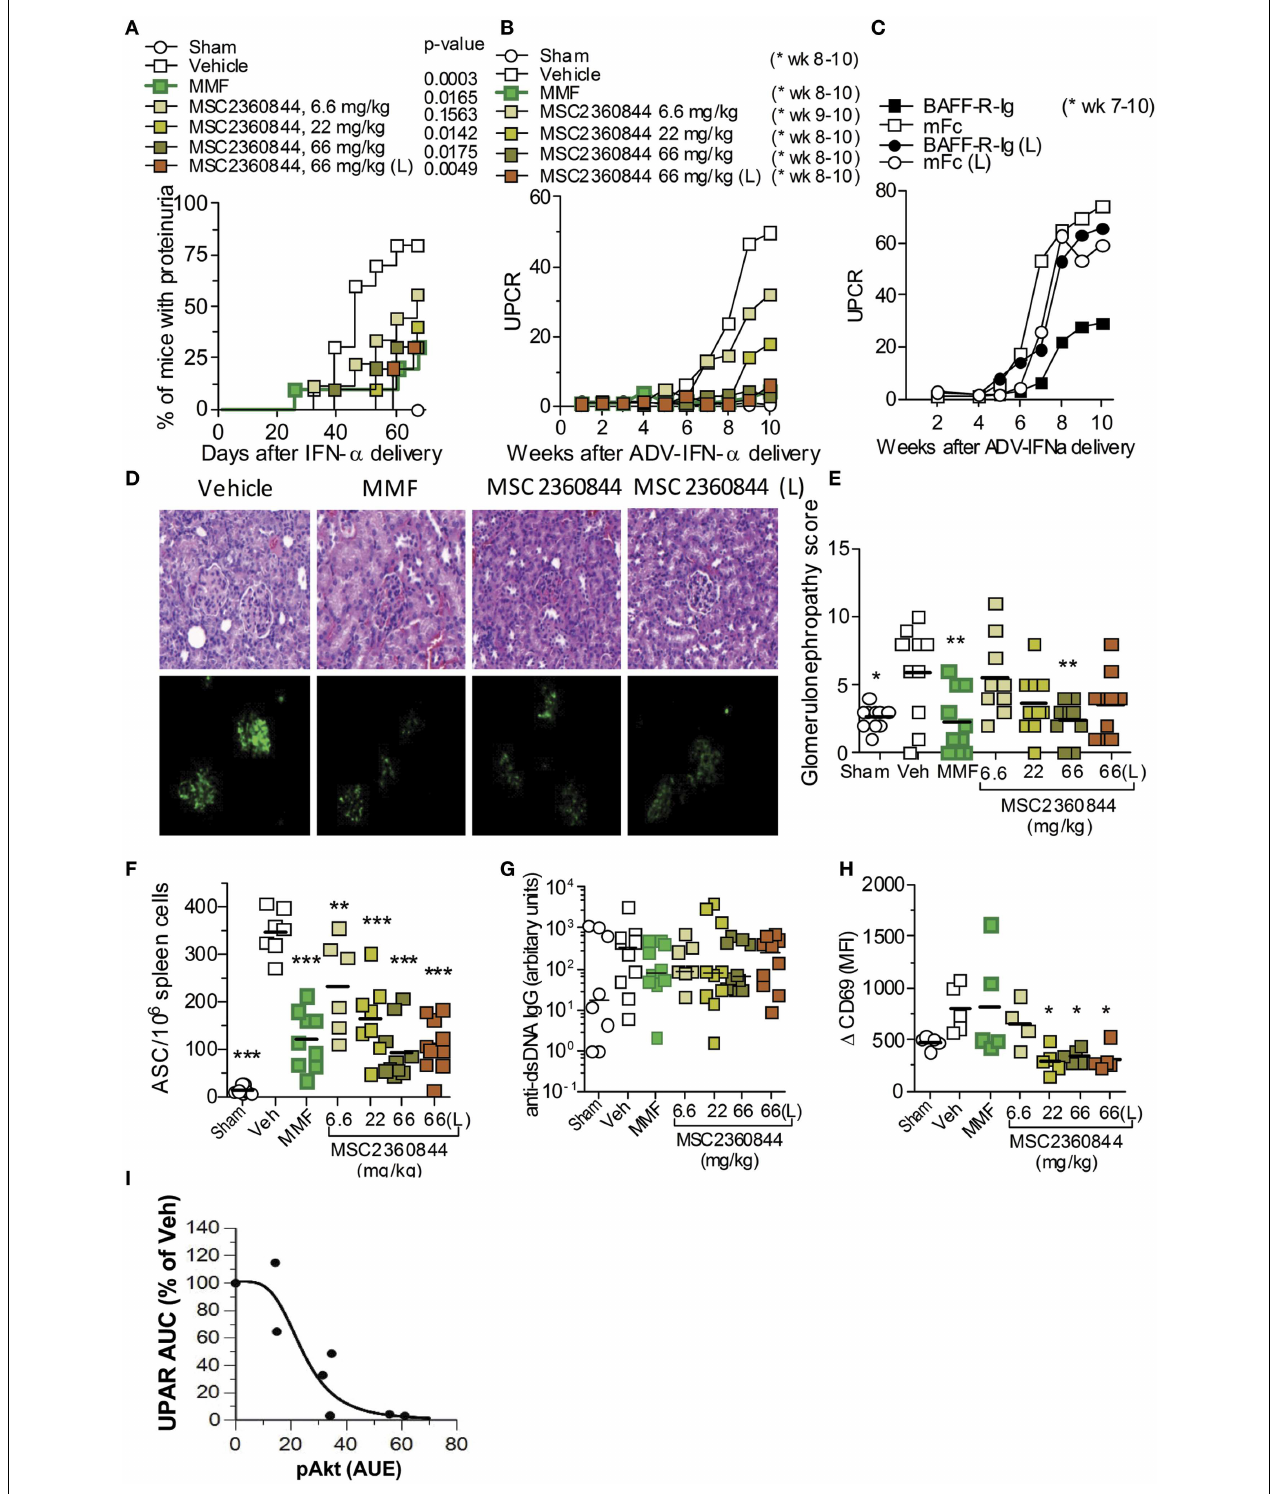
FIGURE 6 | MSC2360844 abrogates lupus nephritis development in accelerated NZB/W F1 SLE model . (A) Incidence of proteinuria and (B) mean UPCR overtime in mice treated once daily with MSC2360844 at 6.6, 22, or 66mg/kg, or MMF at 300mg/kg with an early dosing regimen, or MSC2360844 at 66mg/kg with a late dosing regimen (L).